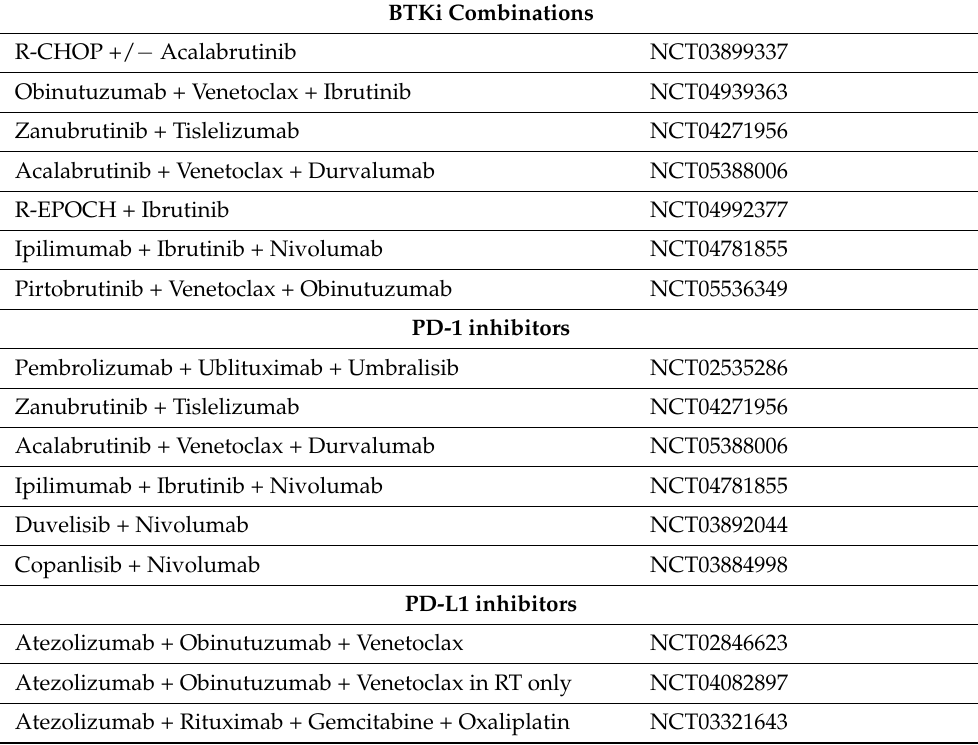
Table 3. Ongoing clinical trials in